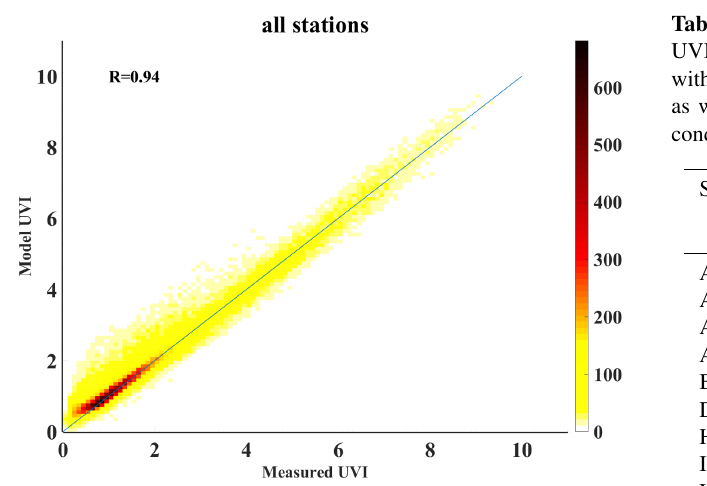
Figure 5. Density scatterplot of the overall UVIOS performance for all stations. The analytical statistics for each station can be found in Appendix A.